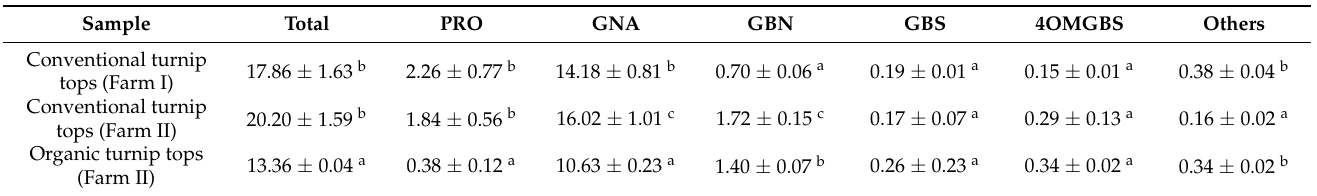
Table 7. Content ( µ mol/g dry weight) of total and individual glucosinolates in turnip tops (mean ± standard